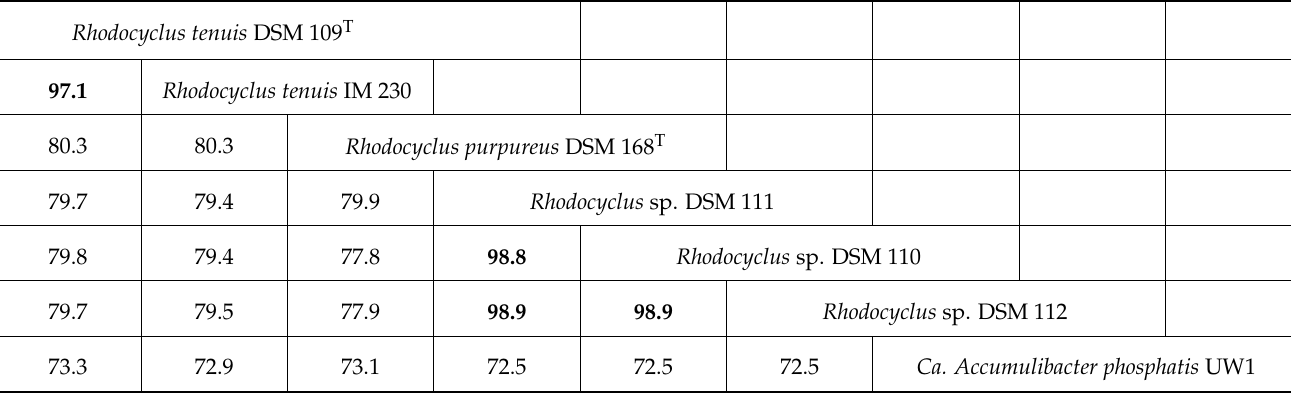
Table 2. Whole-genome-based average nucleotide identity (ANI) of Rhodocyclus species and relatives. ANI values above the species cutoff of 95% are shown in